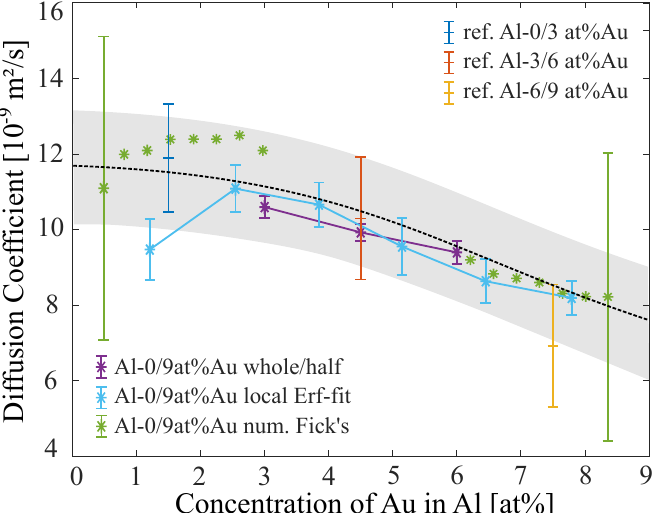
Figure 6. Diffusion coefficients from different analyzing approaches performing on a 0/9 at% Au- content in Al experimental data set at 1000 ◦ C. The error bars of the Numerical Fick’s Law Approach are of the same size, but not all were plotted in favor of a clearer layout. Reference measurements were done for smaller concentration gradients 0/3-3/6-6/9 at% Au-content in Al. The black dotted line represents an approximated concentration dependence for the diffusion coefficient in Al–Au from all the results of the analyzing